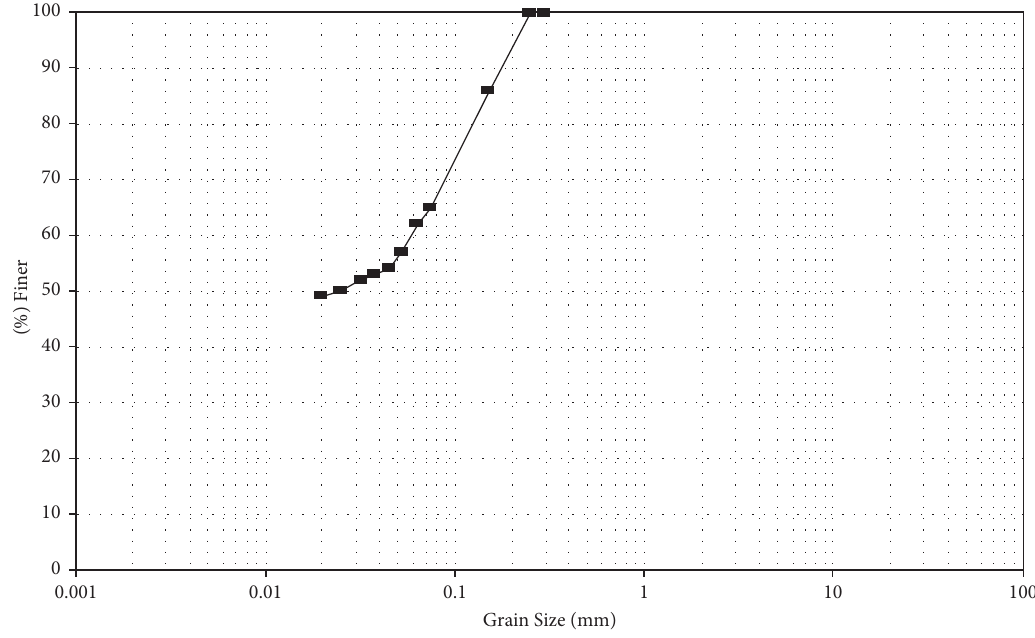
Figure 9: Particle size distribution of BCS.